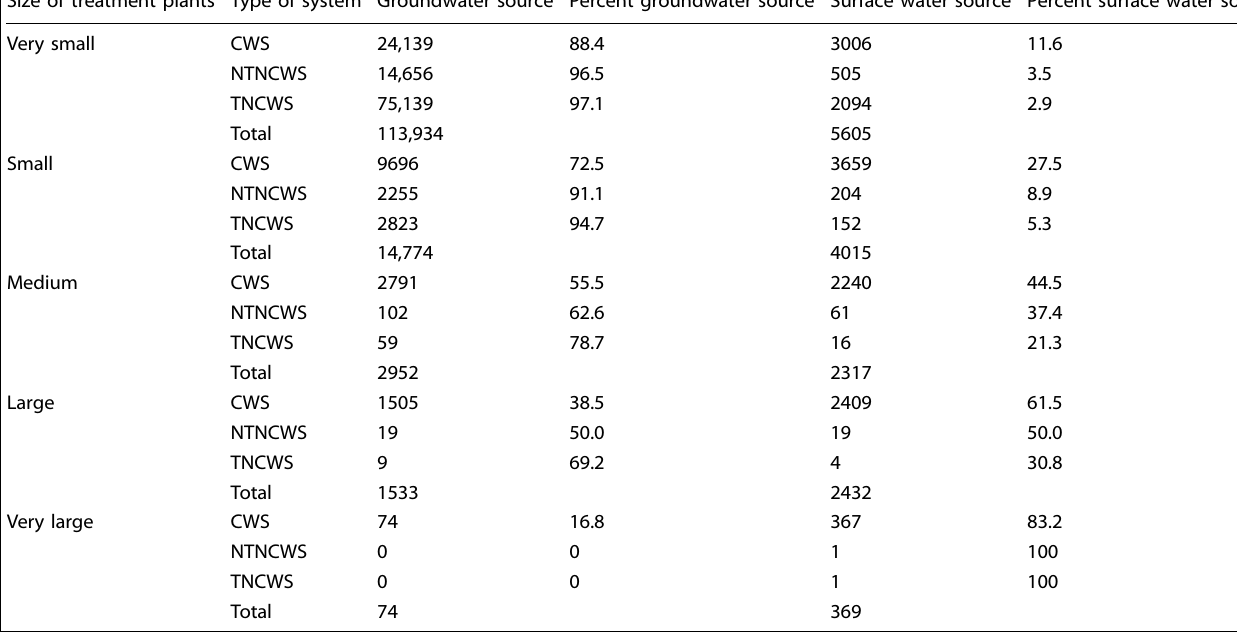
Table 3. Type of system vs. source in different size of treatment plants 30 .